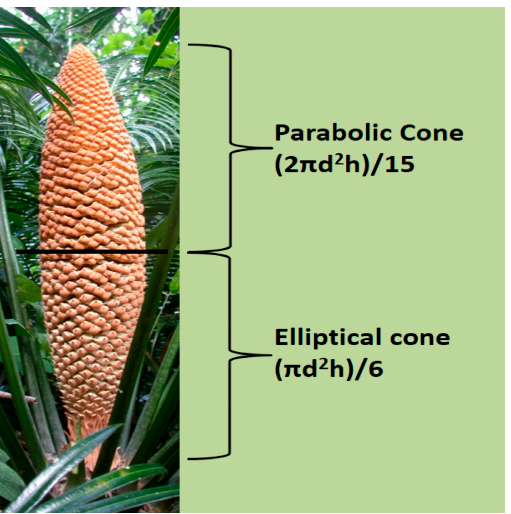
Figure 1. The volume of each Cycas micronesica microstrobilus was calculated by assigning the formula for the parabolic cone to the apical half and the formula for the elliptical cone for the basal half. d = maximum diameter, h = height.